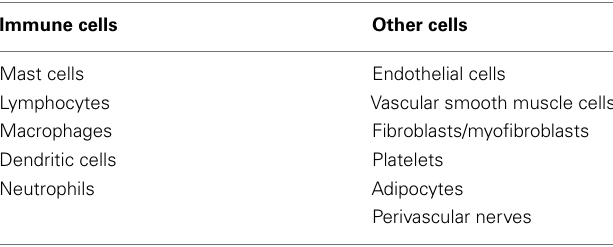
Table 1 | Cellular targets and sources for neurotrophins as potentially related to atherogenesis a